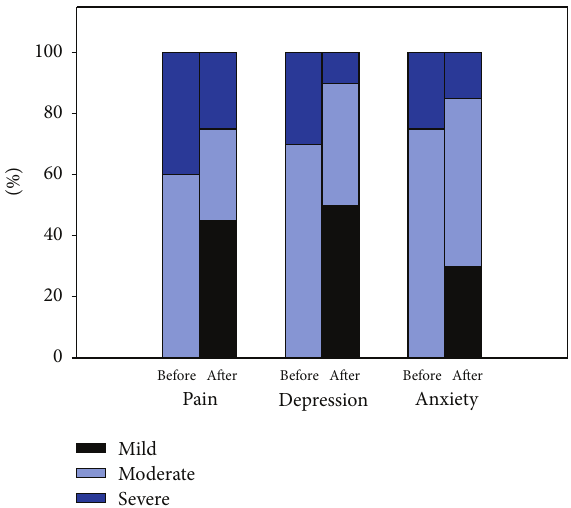
Figure 1: Perception of severe pain depression and